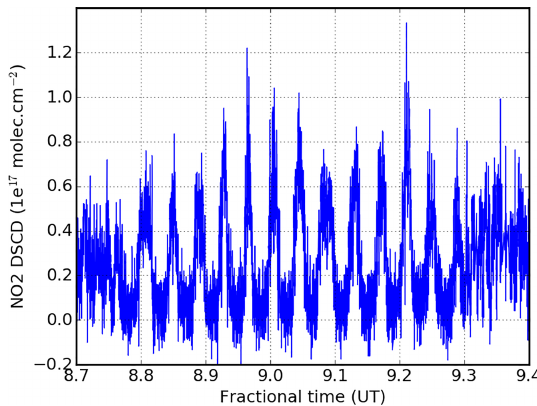
Figure 8. Time series of the NO 2 DSCDs fitted in the first flight on 11 September